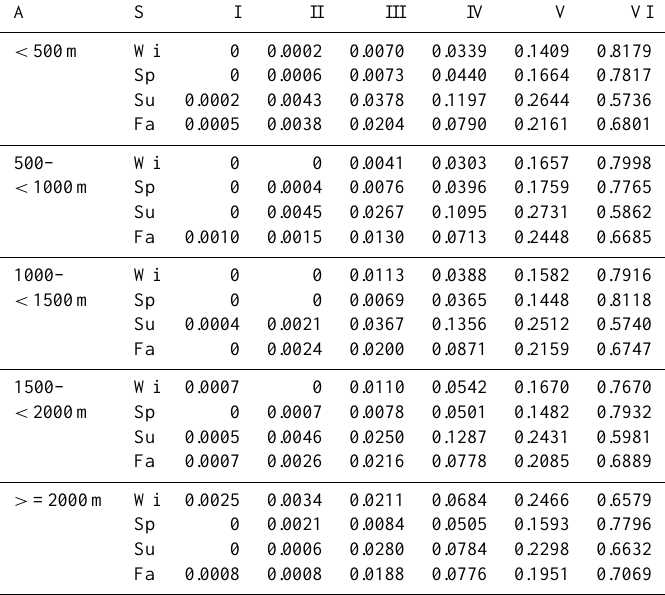
Table D4. Probabilities of cloud coverage classes for a 24h precipitation sum of > 4–10cm depending on explanatory variables following selected Swiss climate stations. For further description see Table D2.